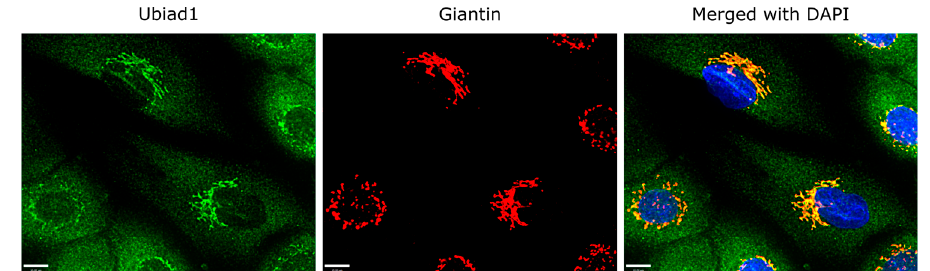
Figure 2. Expression of Ubiad1 in human keratinocytes. Immunodetection of Ubiad1 (green), Giantin (red) and DNA stained with DAPI (blue), protein co-localization (yellow) in cultured human keratinocytes, Pearson’s correlation coefficient for cells in middle of the field is relatively high 0.79 and 0.77 (×63 objective lens, scale bar = 10 µm).